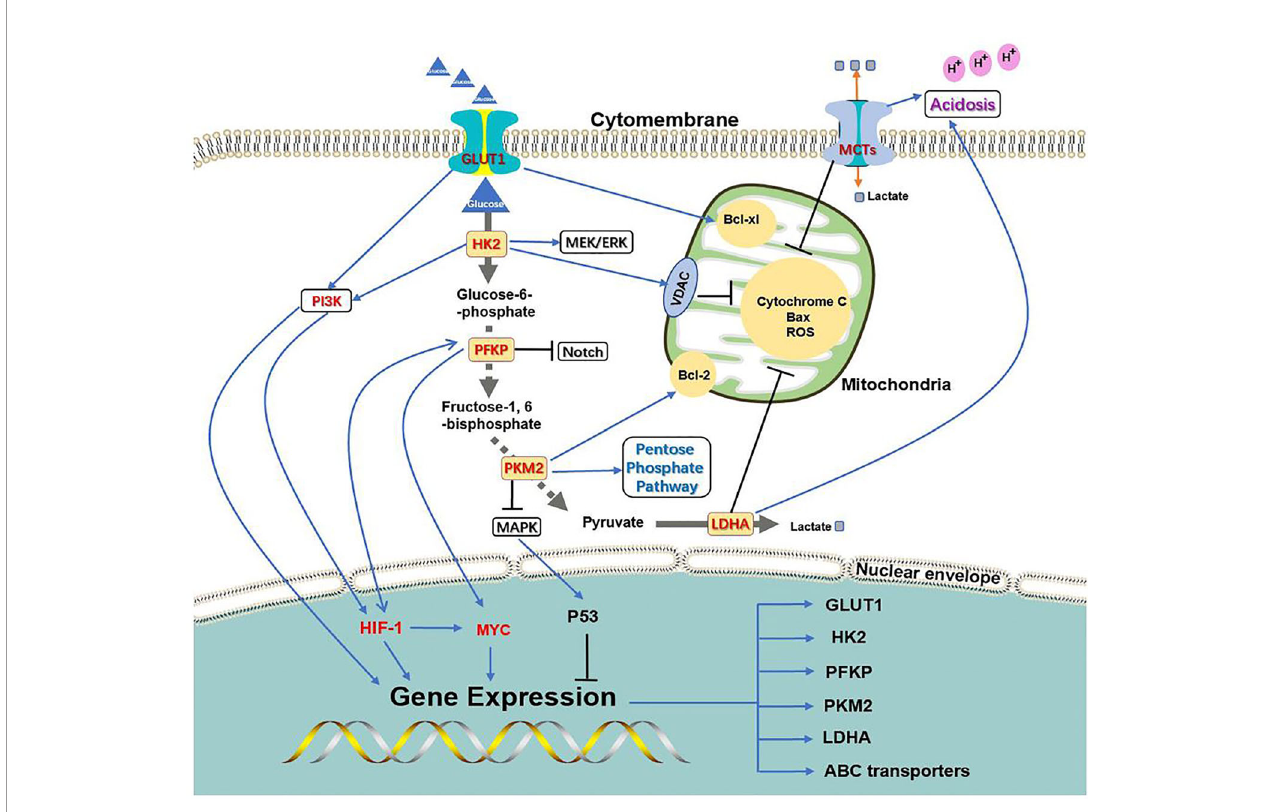
FIGURE 2 | Association between glycolysis transporter, key enzymes, and PI3K, HIF-1, C-MYC signaling pathways. PI3K, HIF-1, and C-MYC signaling pathways can activate the expression of key glycolysis enzymes and transporters to ensure cancer metabolism and energy supply; at the same time, the key enzymes and transporters of glycolysis can activate chemoresistance-related signaling pathways through their own or other protein